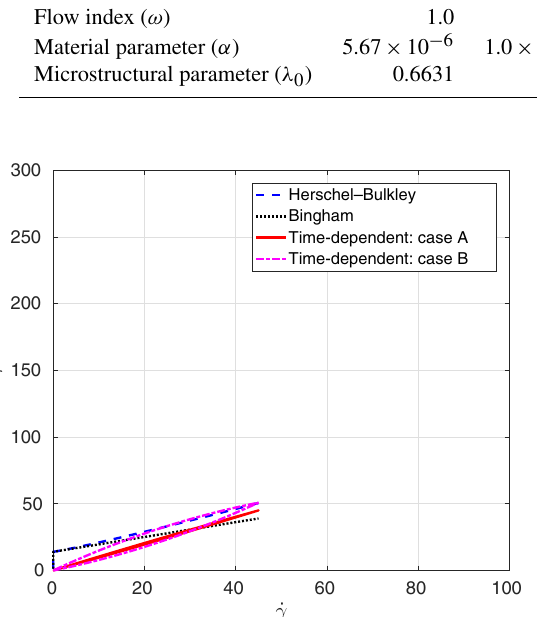
Figure 6. Analytical stress–strain for thixotropic avalanche case 3: shear stress (Pa) and rate of strain (s − 1 ) with τ 0 = 14Pa and τ c = 50Pa. The τ axis is scaled for comparison with Figs. 4 and 5, while the ˙ γ axis has an individual scale for clarity. Figure 7. Thixotropic avalanche case 1: comparison of numerical results and experimental data for non-dimensional front displace- ment ( x ∗ ) as a function of non-dimensional simulation time ( t ∗